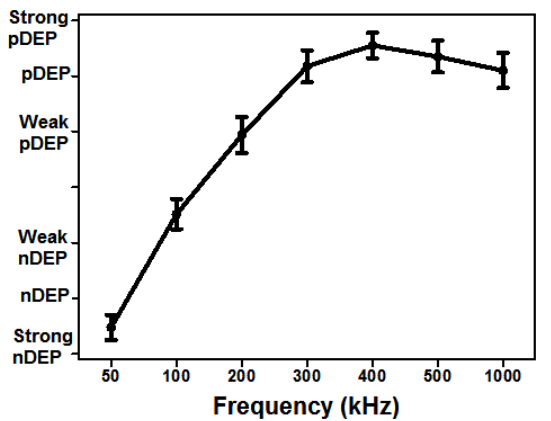
Figure 3. Dielectrophoretic behavior of the viable U937 monocytes. The electrode region was aligned with a grid that shows the strong nDEP ( − 3), nDEP ( − 2), weak nDEP ( − 1), crossover (0), weak pDEP (1), pDEP (2) and strong pDEP (3) behaviors of the cells. The mean values with the standard deviations represent 80